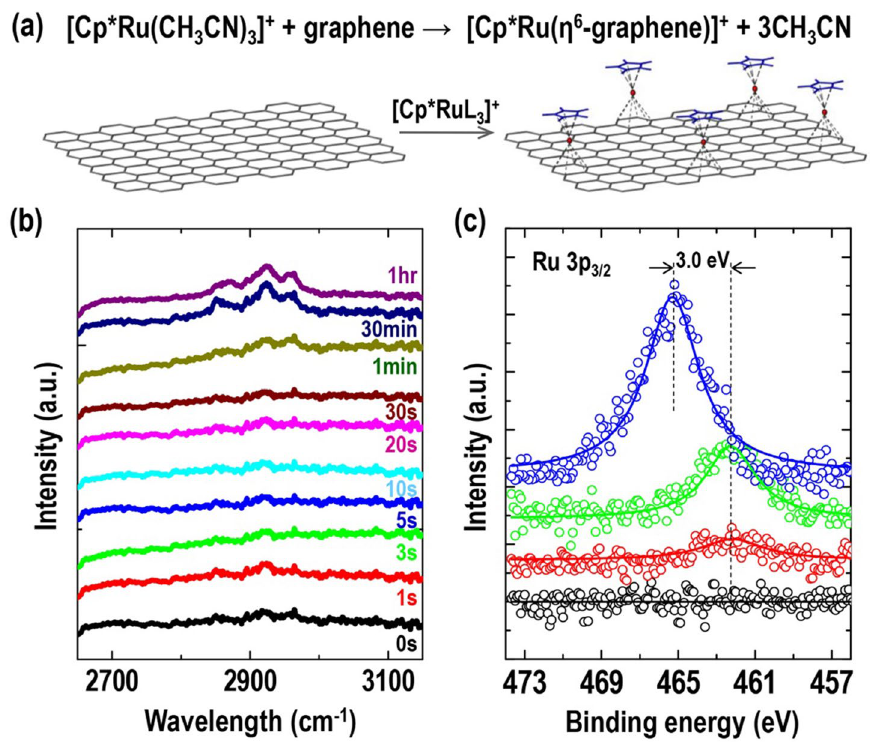
Figure 1. ( a ) Schematic illustration of chemical reaction between [Cp * Ru(CH 3 CN) 3 ] + and graphene surface. ( b ) FT-IR spectra of graphite as a function of reaction time in 1.25 mM Cp * RuL 3 PF 6 solution. ( c ) XPS spectra of Ru 3p 3/2 signal regions for pristine graphite (black), Cp * Ru + -graphites reacted with 1.25 × 10 −7 M (red) and 1.25 mM (green) solutions, and dried 1.25 × 10 −7 M Cp * RuL 3 PF 6 on glass (blue).